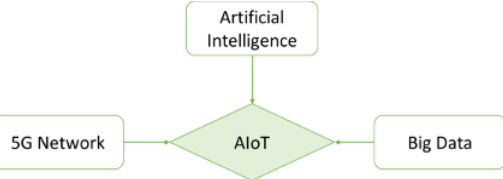
Fig. 1. the key emerging technologies of the Artificial Intelligence of